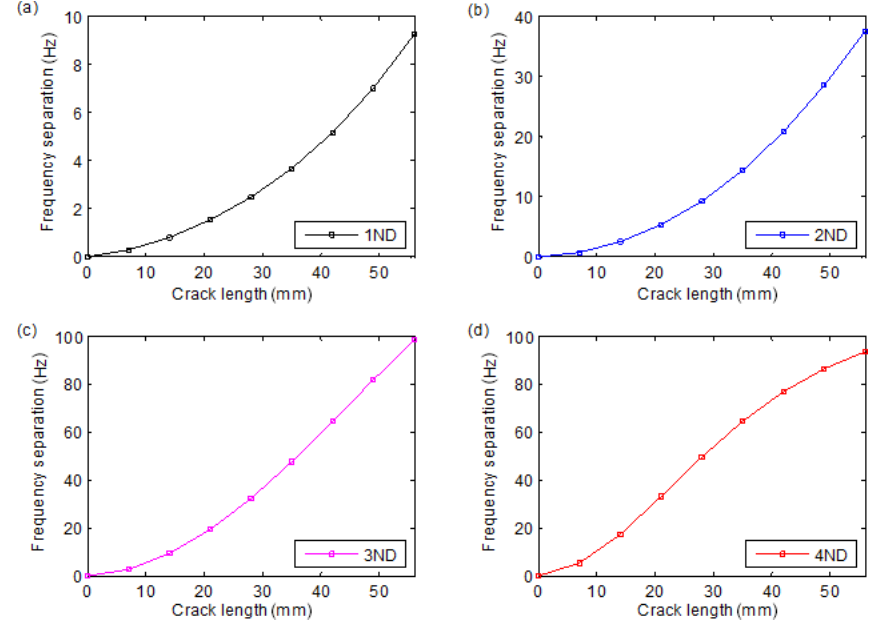
Figure 7. Separations of the 1ND, 2ND, 3ND and 4ND natural frequency pairs versus crack length.